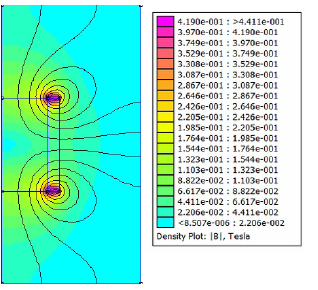
Figure 1. Magnetic flux density